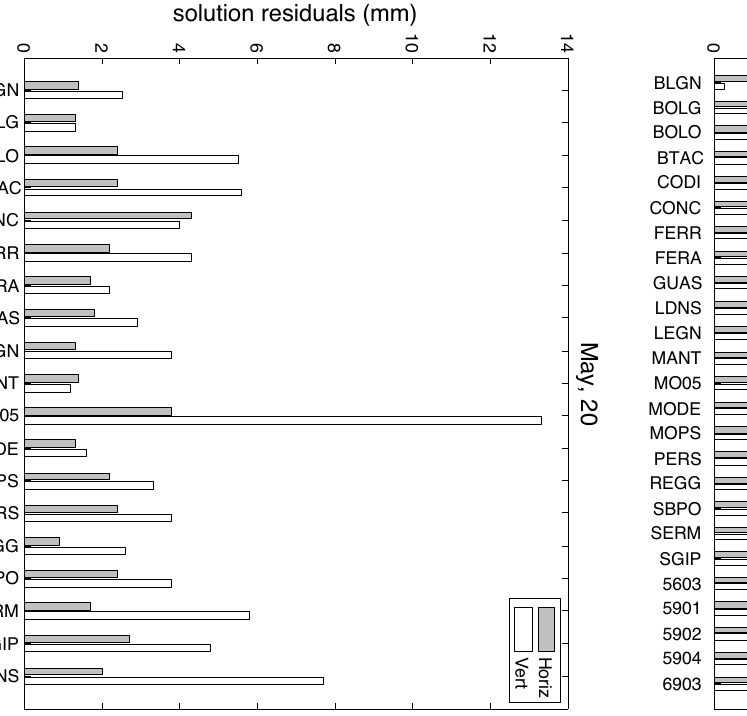
Figure 3. Cumulative WRMS of the station offset differences between the individual May 20, 2012, solutions (BERNESE, GAMIT and GIPSY) for the horizontal (gray) and vertical (open bar) components.